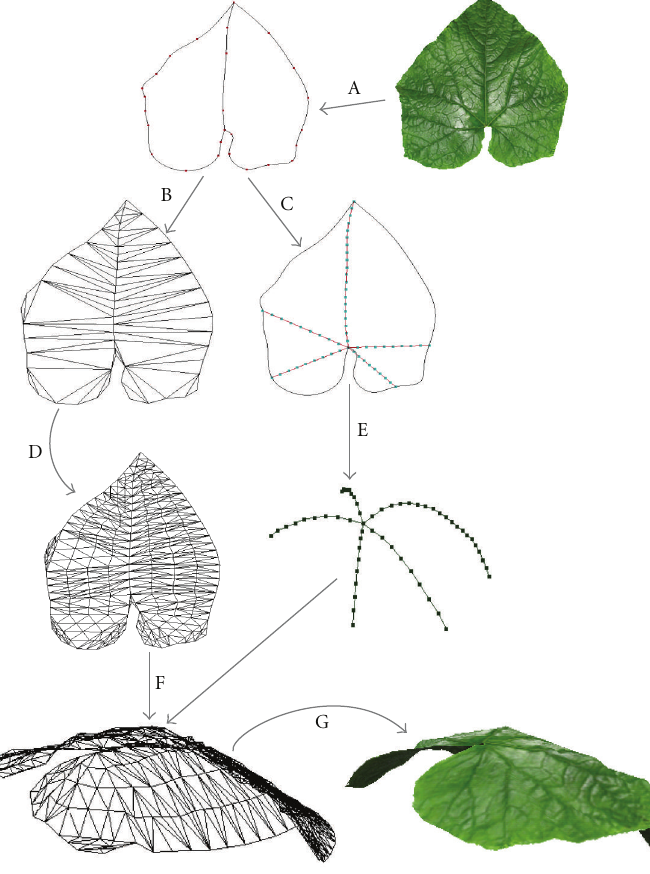
Figure 2: Modeling